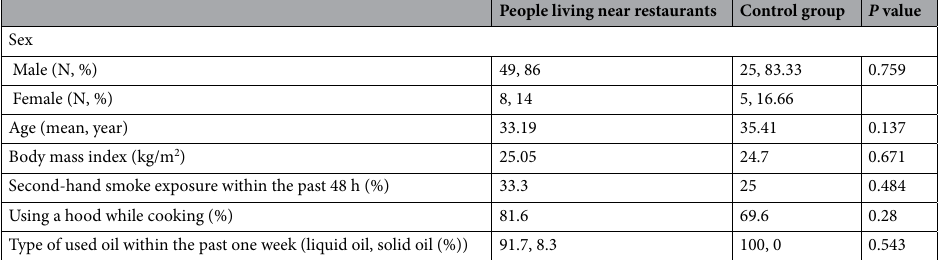
Table 1. Comparison of the people living near restaurants and the control group regarding demographic